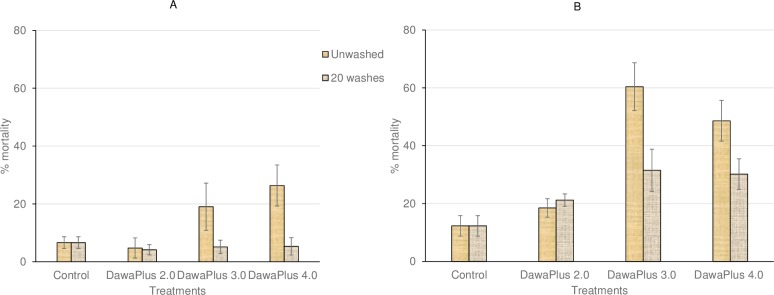
Mortality of An. gambiae s.l. adults emerged from field collected larvae in Vallée du Kou in cone bioassays performed in situ on the nets using WHO cones.Bars show mortality rates at the beginning of the trial (A) and at the end of the trial (B) with unwashed and 20-times washed nets. Error bars represent 95% confidence intervals.